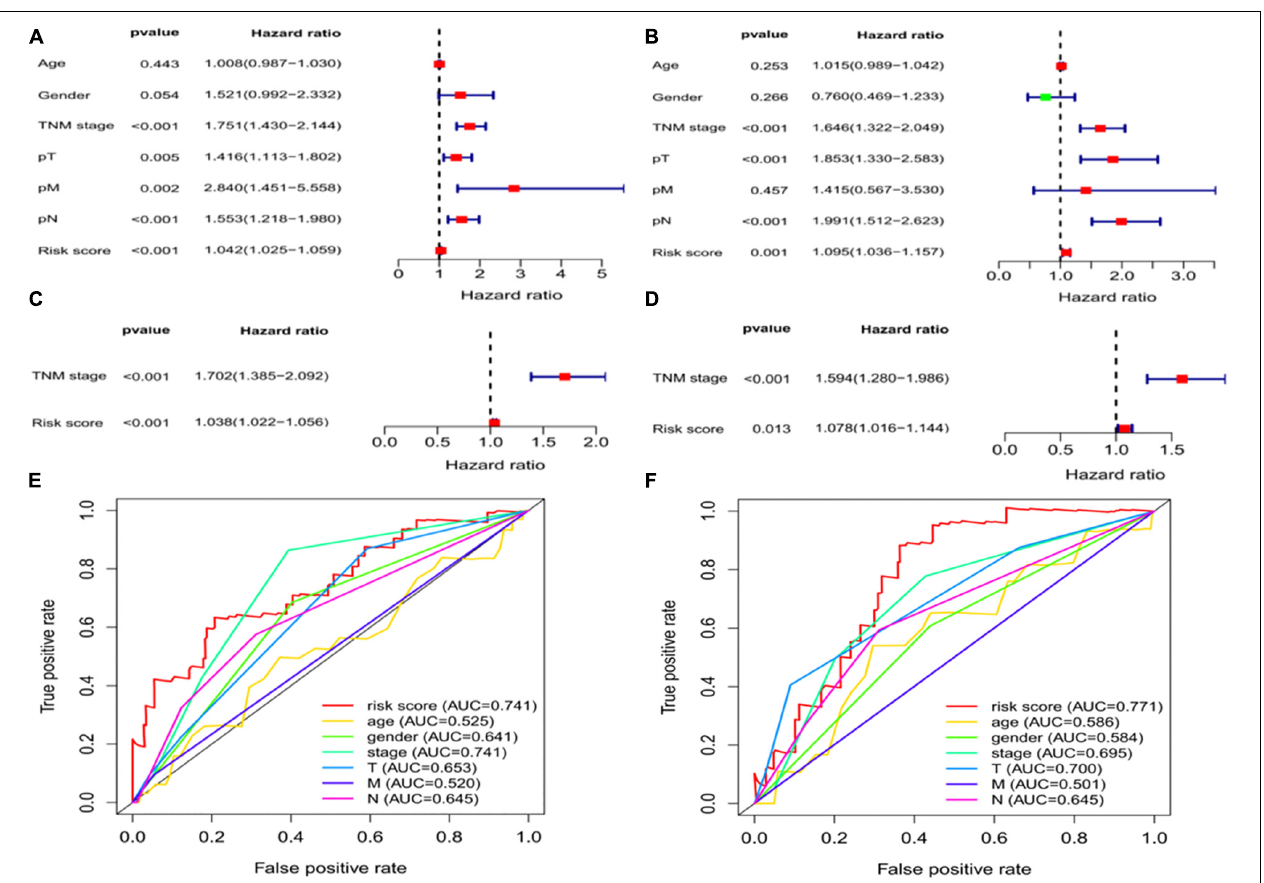
FIGURE 5 | Independent prognostic factors for LUAD overall survival. Univariate Cox regression analysis in the (A) training and (B) validation sets. Multivariate Cox regression analysis in the (C) training and (D) validation sets. Receiver operating characteristic curves of risk scores and other clinical characteristics based on overall survival in the (E) training and (F) validation sets. LUAD, lung